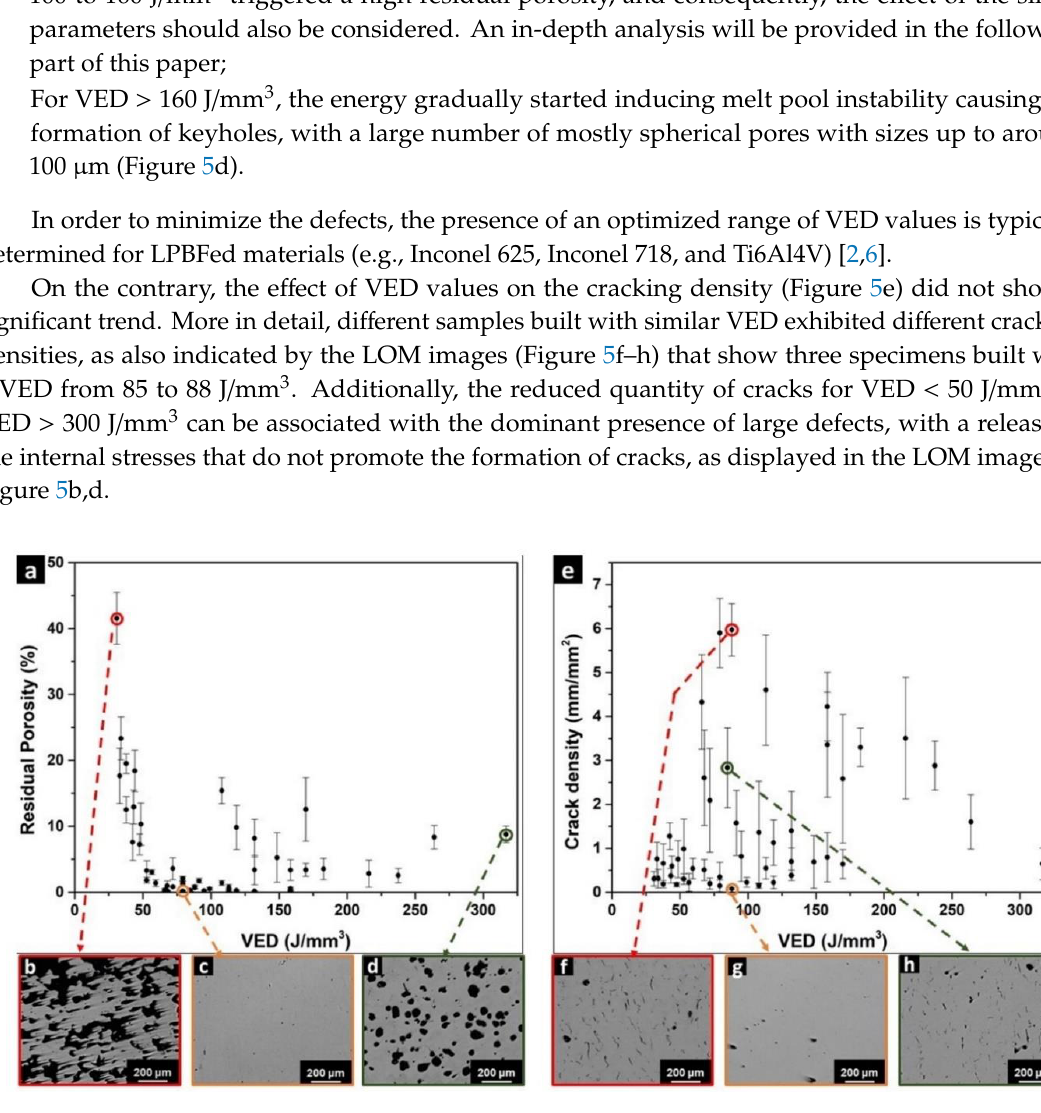
Figure 5. ( a ) Effect of volumetric energy density (VED) on the residual porosity of LPBFed IN939; ( b – d ) LOM images of representative conditions revealing the different shapes and sizes of the detected pores; ( e ) Effect of VED on the cracking density of the LPBFed IN939; ( f – h ) LOM images of representative conditions with very similar VED (85–88 J/mm 3 ) showing different dimensions and concentrations of cracks.